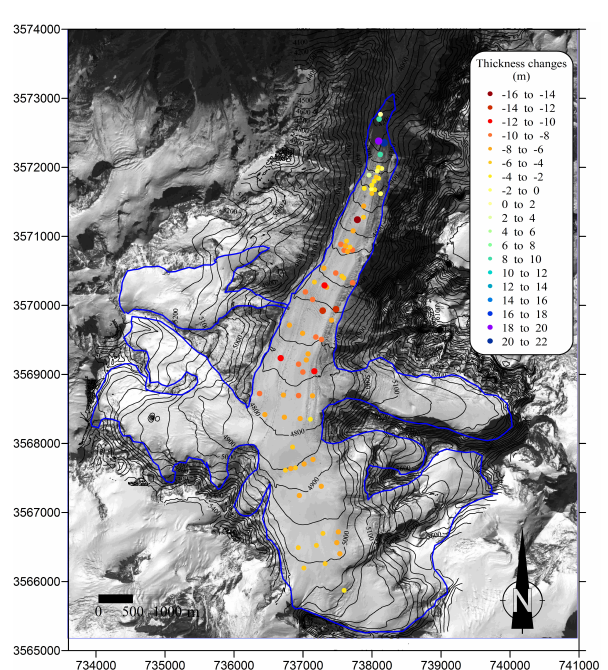
Fig. 2. Thickness changes of the Chhota Shigri Glacier measured between 1988 and 2010, using geodetic measurements (coloured dots). The map coordinates are in the UTM43 (north) WGS84 (World Geodetic System) reference system.